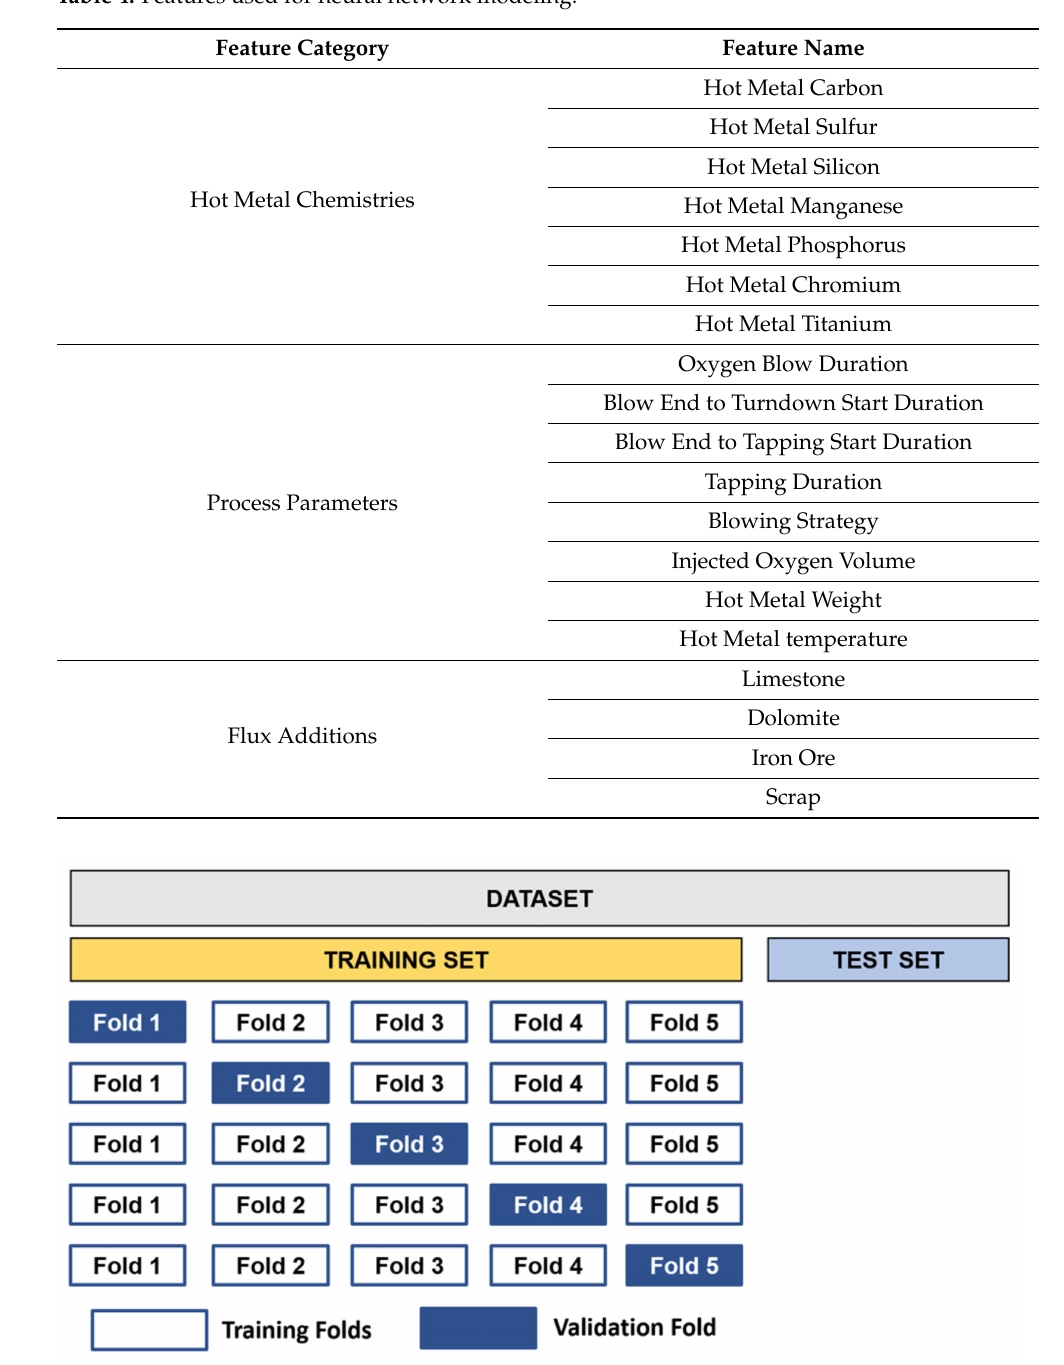
Figure 7. Schematic diagram of five-fold cross-validation. Root mean squared error (RMSE) is selected as the evaluation metric for endpoint predictions. It is defined